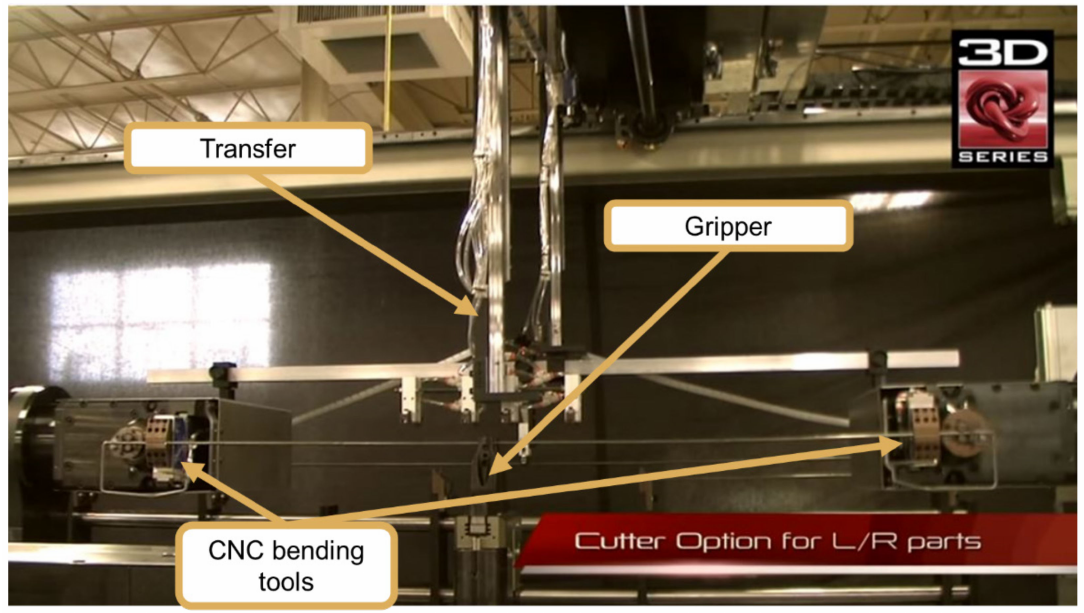
Figure 13. Upper transfers of Gemini